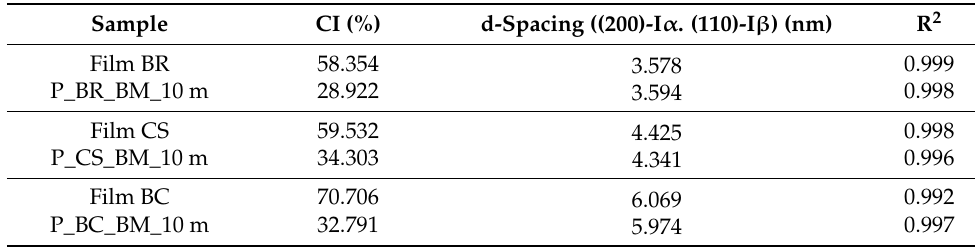
Table 4. CI (%) calculated for the different samples with background subtraction and intensity correction.